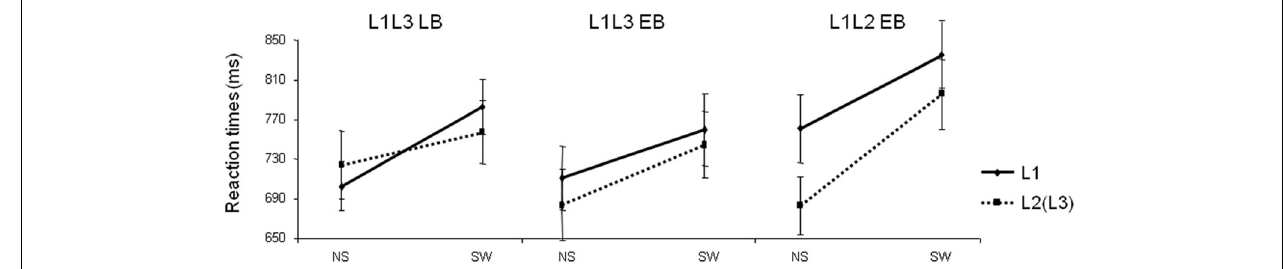
FIGURE 1 | Mean naming latencies (reaction times in milliseconds) of Late L3 learners (L1L3 LB), Early bilingual L3 learners (L1L3 EB), and Early bilinguals switching between their two dominant languages (L1L2